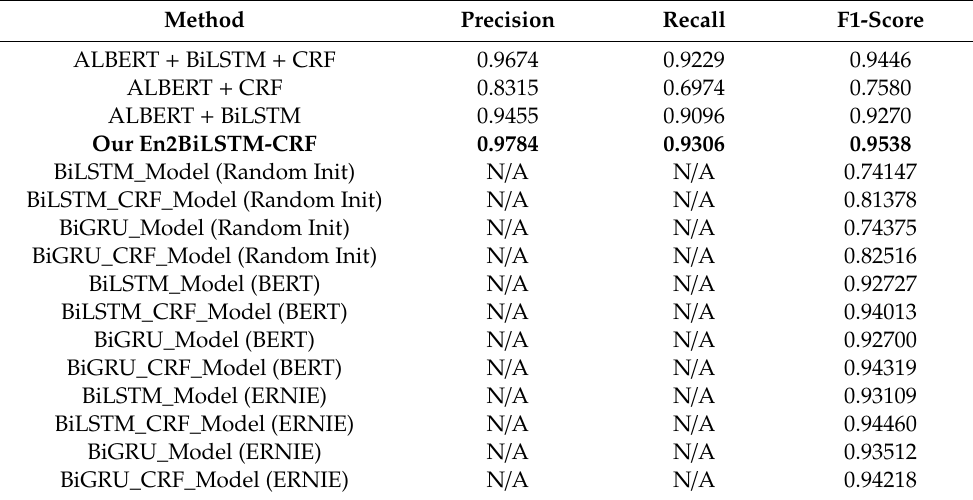
Table 4. Comparison with di ff erent baselines on the People’s Daily Ner